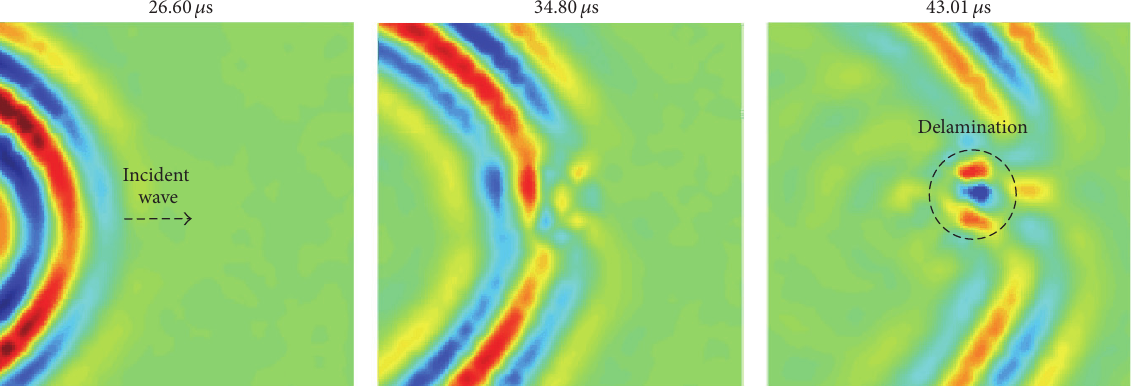
Figure 5: Representative 𝑊 𝑇 images at 26.60 𝜇 s, 34.80 𝜇 s, and 43.01 𝜇 s.